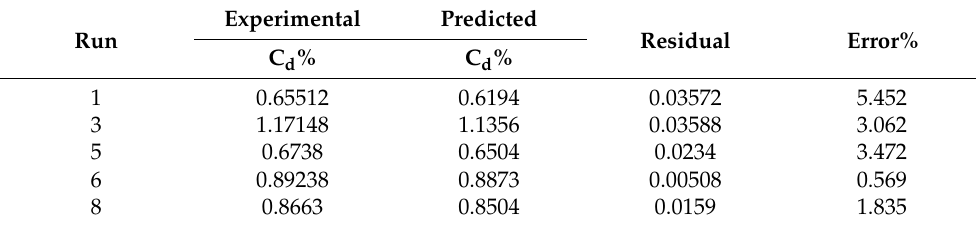
Table 8. Confirmed results for the developed